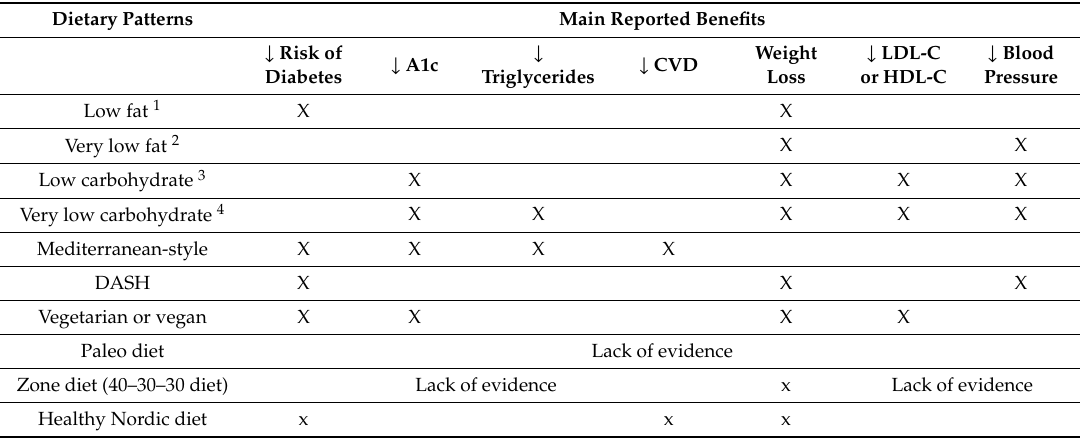
Table 2. Metabolic syndrome improvement observed with di ff erent dietary patterns. DASH—Dietary approaches to stop hypertension; CVD—Cardiovascular disease; LDL-C—Low-density lipoprotein cholesterol; HDL-C—High-density lipoprotein